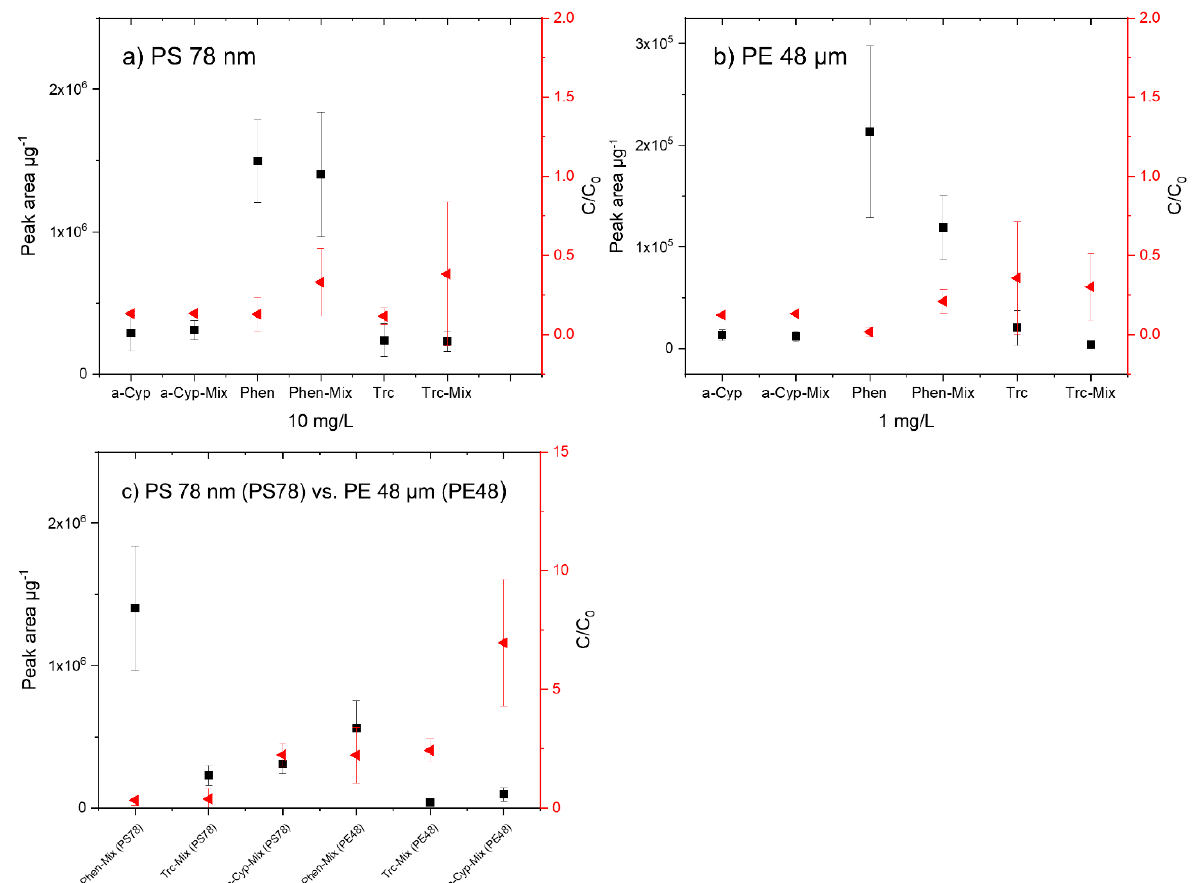
Figure 6. Comparison of the results of the measured single substances ( α -cypermethrin (a-Cyp), Phenanthrene (Phen), and Triclosan (Trc)) and the measurement of the mixed TOrCS (a-Cyp-Mix, Phen-Mix, Trc-Mix) with an initial concentration of 10 mg/L and sorption on PS 78 nm ( a ), with an initial concentration of 1 mg/L and sorption on PE 48 µ m particles ( b ), and with an initial concentration of 10 mg/L on PS78 nm and PE 48 µ m ( c ); measurements of the aqueous phase were conducted via Gerstel Twister ® and TD-GC/MS measurements of the particles were carried out with TD-Pyr-GC/MS. On the left y − axis (black, square), the sorption on the particles (peak area µ g − 1 ) is shown; on the right y − axis (red, triangle), the concentration in the aqueous phase (C/C 0 ) is